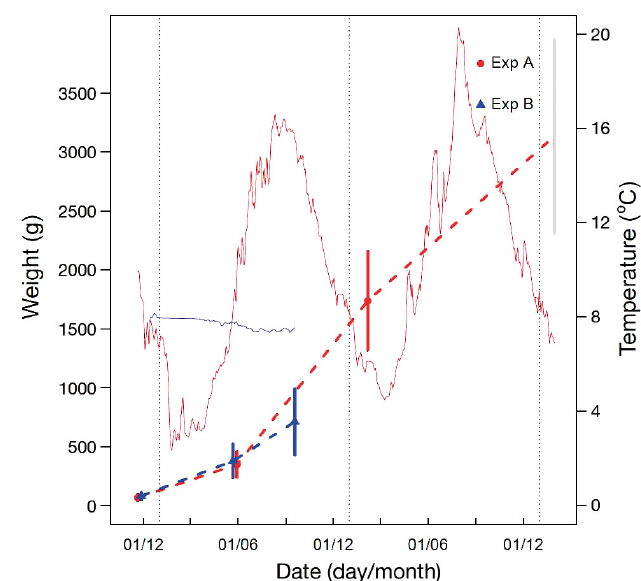
Fig. 2. Overall cod weight (left axis) and water temperature (right axis, solid lines) in Expt A (red) and Expt B (blue). Weight is given as mean ± SD for all crosses pooled. Due to a mortality incidence during summer 2014, the last datapoint for Expt A represents only approximately 45% of the individ- uals present in the previous measurements (SD is shown in grey for this point). Dates are from Nov 2012 to Jan 2015; dotted vertical lines show each 1